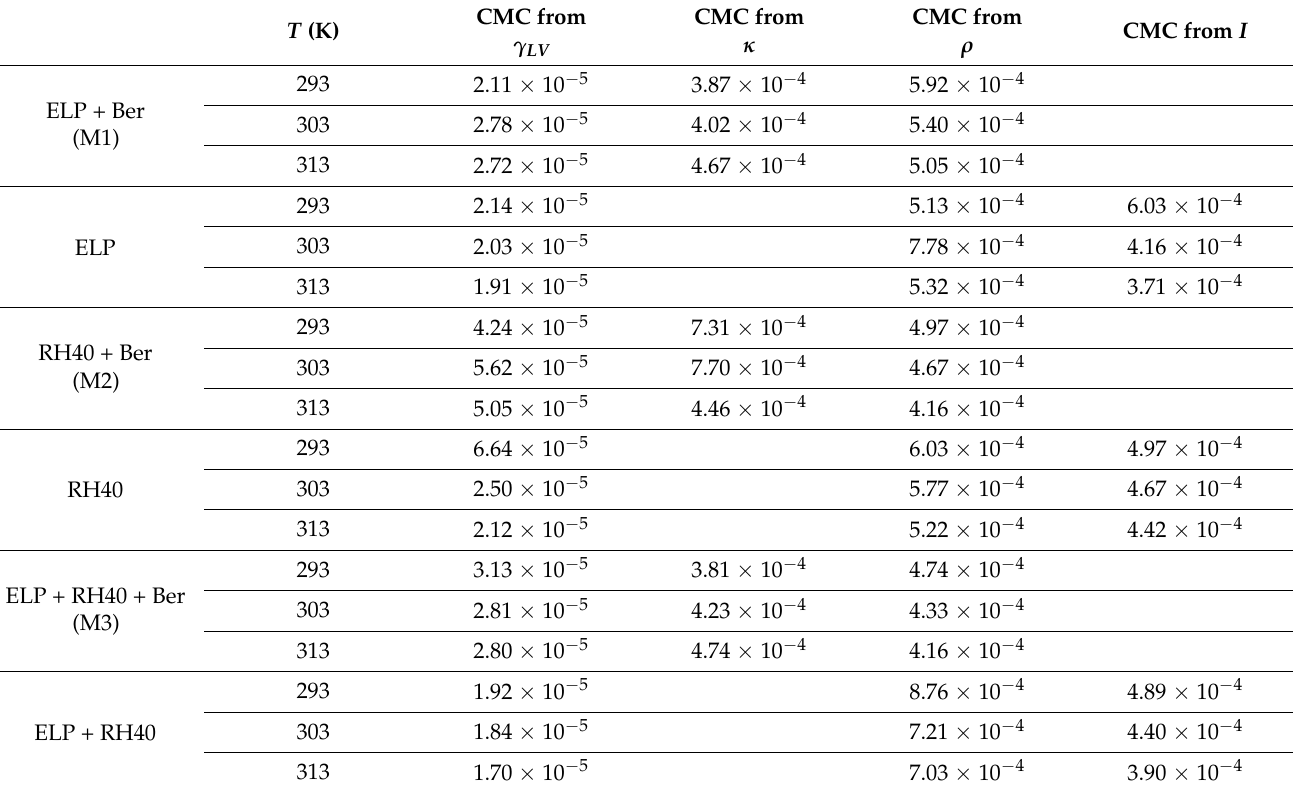
Figure 8. Fluorescence emission spectra of mixture M1 at T = 293 K. Table 2. The values of the CMC (mol/dm 3 ) of the aqueous solutions M1, M2, and M3 mixtures as, well as ELP, RH40 and their mixture at T = 293, 303, and 313 K, determined from the surface tension isotherms ( γ LV = f(log C )), conductivity ( κ = f(1/ C )), and density ( ρ = f(1/ C )) measurements, as well as fluorescence emission spectra ( I = f(1/ C )). The values of CMC for ELP, RH40, and their mixture, determined from surface tension measurements, are taken from Ref. [22].